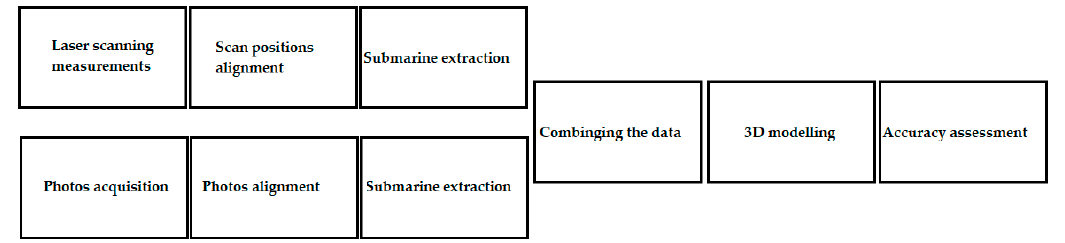
Figure 1. PNS Jastrzab—decommissioned submarine—object of research: ( a ) wet object during laser scanning with control points, ( b ) general view of the submarine (source: by Pawel Kusiak , CC BY-SA 4.0, https://commons.wikimedia.org/w/index.php?curid=42676502).